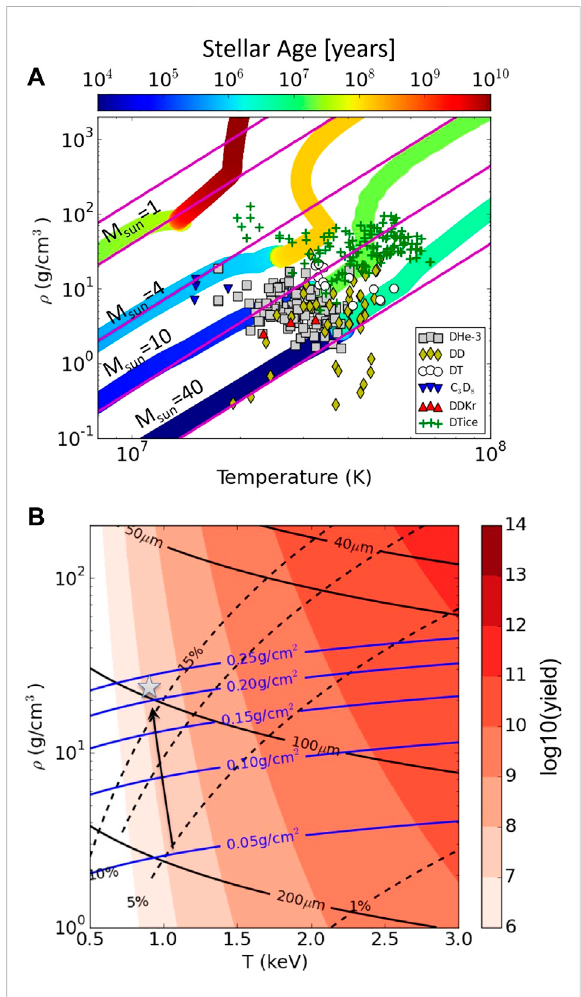
FIGURE 1 (A) Stellarconditionscomputedfortheevolutionofstarswith 1, 4, 10, and 40 solar mass compared with NIF experiments. (B) Design space considering various requirements of a potential screening experiment. The arrow illustrates how current experiments need to be modi fi ed to reach an optimum in design space (the star) that balances various design